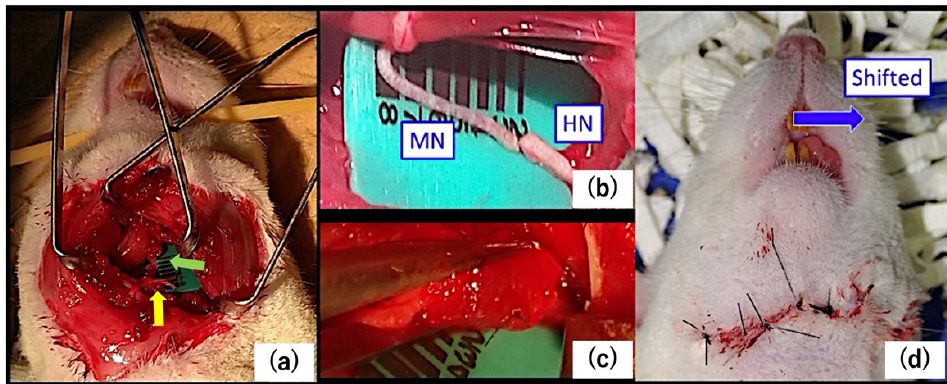
Figure 7. The surgical procedure. ( a ) Weakly magnified surgical photograph. The masseteric nerve (MN: yellow arrow) and the hypoglossal nerve (HN: green arrow) were exposed. ( b ) The MN and the HN were anastomosed. ( c ) The artificial nerve was used as a bridge. ( d ) The tongue was shifted to the direction of the non-operative side (blue arrow) after the surgery.